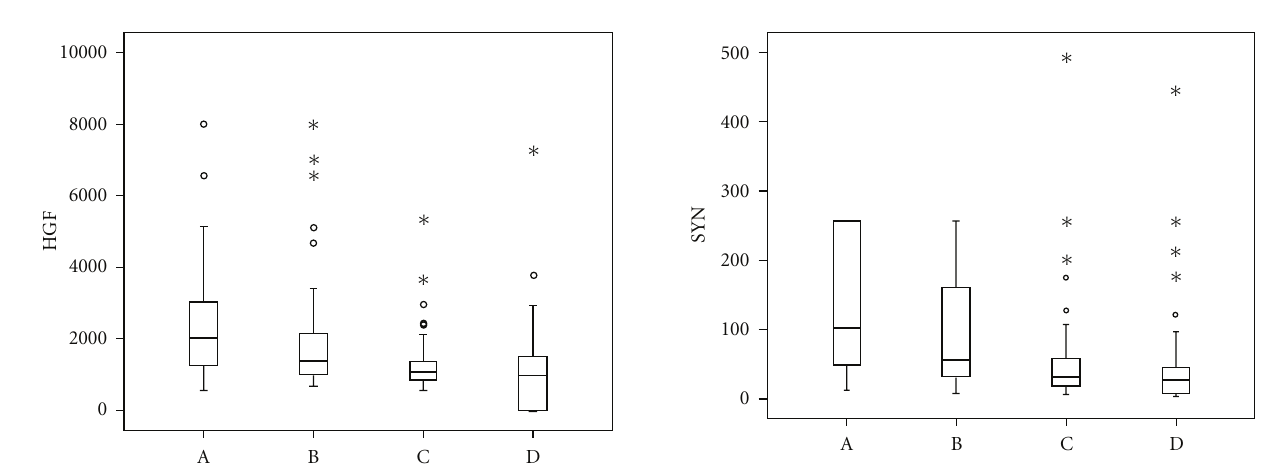
Figure 1: Comparison of serum levels of hepatocyte growth factor (HGF) in di ff erent phases of multiple myeloma and in monoclonal gammopathy of undetermined significance. Vertical axis: serum levels of hepatocyte growth factor (HGF, pg/mL). Horizontal axis: (A) multiple myeloma at the time of diagnosis, (B) multiple myeloma (MM) in relapse/progression, (C) remission phase mul- tiple myeloma, (D) monoclonal gammopathy of undetermined significance (MGUS). The di ff erences between active phase MM (A versus B) and remission phase myeloma and MGUS (C and D) were not statistically di ff erent. Significant di ff erences were found between MM at the time of diagnosis and remission phase myeloma (A versus C; M 2001,0 versus 1049,0 pg/mL, P < 0,0001), MM at the time of diagnosis and MGUS (A versus D; 2001,0 versus 1228,0 pg/mL, P < 0,0001), MM in relapse/progression and remission phase MM (B versus C; M 1370,0 versus 1049,0 pg/mL, P < 0,0001), and MM in relapse/progression and MGUS (B versus D; 1370,0 versus 1228,0 pg/mL, P = 0,0002).